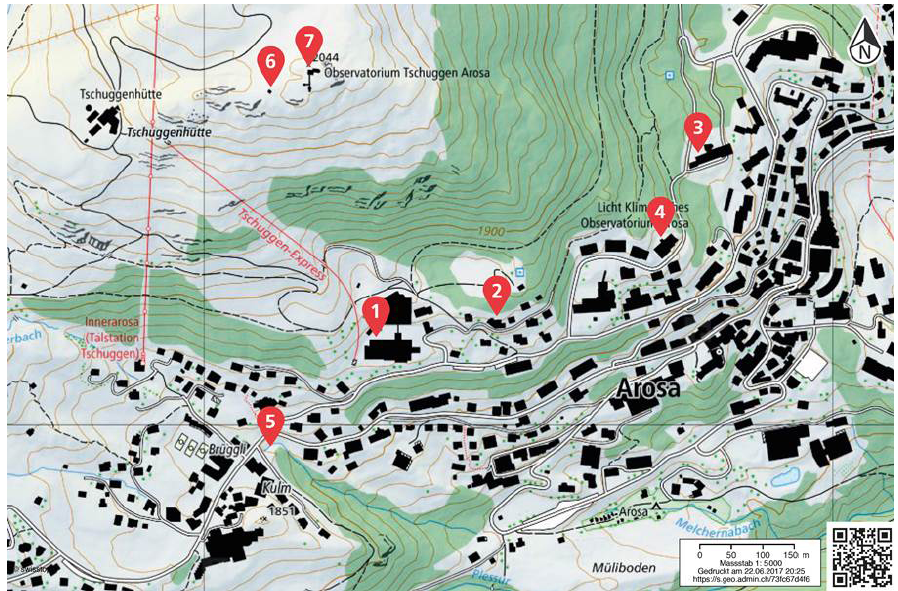
Figure 2. Map of important locations relevant to the Arosa Light Climatic Observatory (LKO). LKO measurement sites: (1) Sanatorium Inner-Arosa; (2) Villa Firnelicht; (3) Florentinum; (4) Haus zum Steinbruch. Other sites: (5) Götzbrunnen (a fountain named in honour of Götz); (6) the hut where Götz made his night-time measurements in Tschuggen; and (7) the astrophysical observatory at Tschuggen. Reproduced with permission from swisstopo (Swiss digital maps, geo.admin.ch).